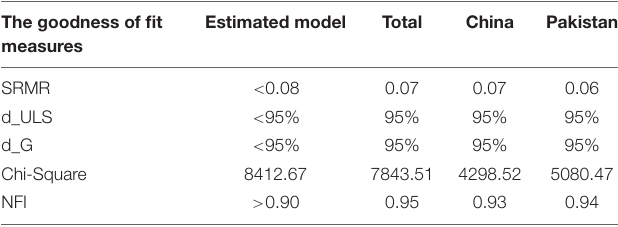
TABLE 3 | Measurements of the model-fit-structural index. TABLE 4 | Measurement model factor loadings of China vs.